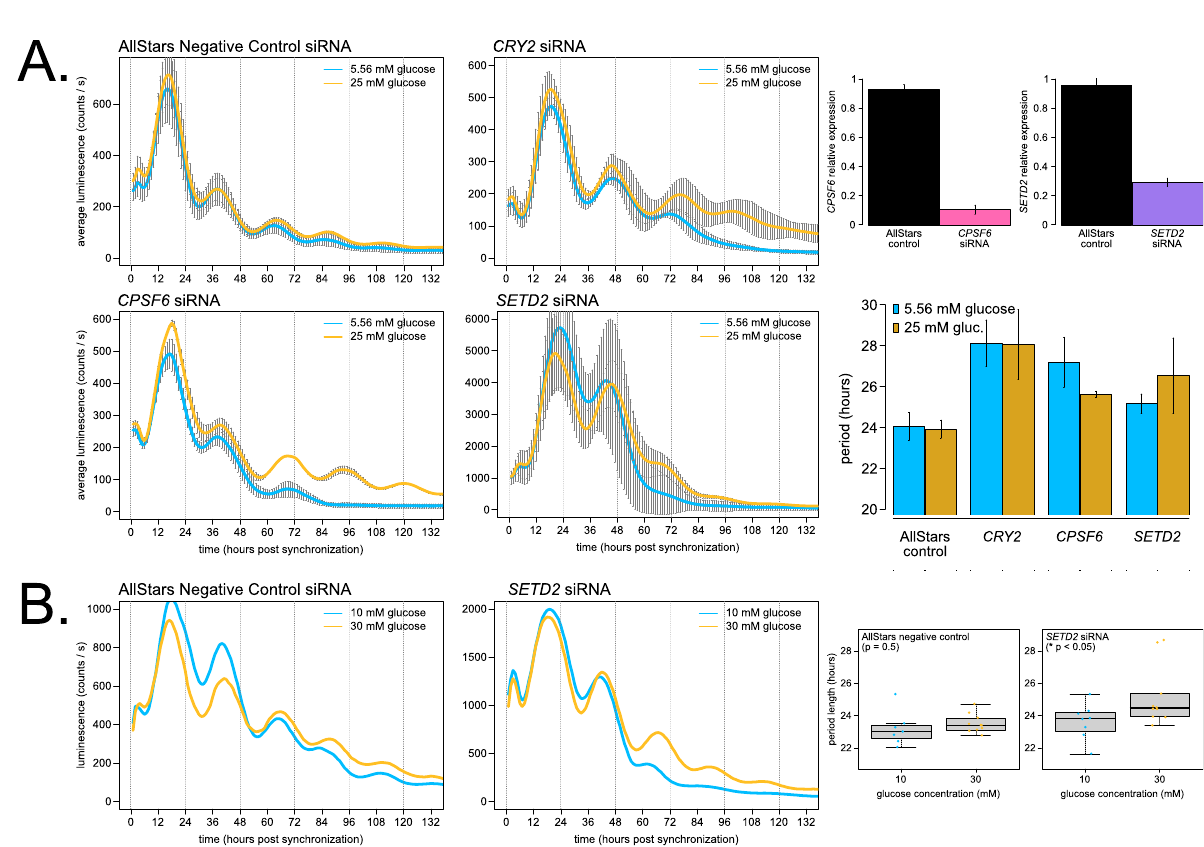
Fig 6. CPSF6 and SETD2 are required for normal Nutritional Compensation of U2OS Bmal1-dLuc cells cultured in high versus low glucose. U2OS cells were transfected with the indicated siRNAs (15 pmol total), incubated for 2 days, and Bmal1-dLuc rhythms were measured for 5–6 days following dexamethasone synchronization. Knocked-down cells were assayed in either MEM high glucose (yellow lines) or MEM low glucose (blue lines) medium. Averaged luciferase traces are shown for each glucose concentration without detrending or further data manipulation ( N = 6 biological/technical replicates for AllStars negative controls; N = 4 biological/technical replicates for other siRNA knockdowns per nutrient concentration; standard deviation error bars). siRNA knockdown efficiency was measured using RT-qPCR relative to nontransfected control samples (Materials and methods). Approximately 90% knockdown was achieved for CPSF6 , and approximately 70% knockdown for SETD2 under these experimental conditions ( N = 2 biological replicate samples each with N = 3 technical replicate RT-qPCR reactions). Period lengths were calculated and averaged for all replicates ( A ). siRNA knocked-down cells were assayed in either DMEM 30 mM glucose (yellow lines) or DMEM 10 mM glucose (blue lines) medium. One representative luciferase trace is shown ( N = 7–10 biological/technical replicates per nutrient concentration). Period lengths were calculated and averaged for all replicates and plotted as boxplots ( B ). Average period lengths were as follows: 23.2 ± 1.1 hours (low glucose control) and 23.5 ± 0.6 hours (high glucose control); 23.6 ± 1.1 hours (low glucose SETD2 knockdown); and 25.2 ± 1.8 hours (high glucose